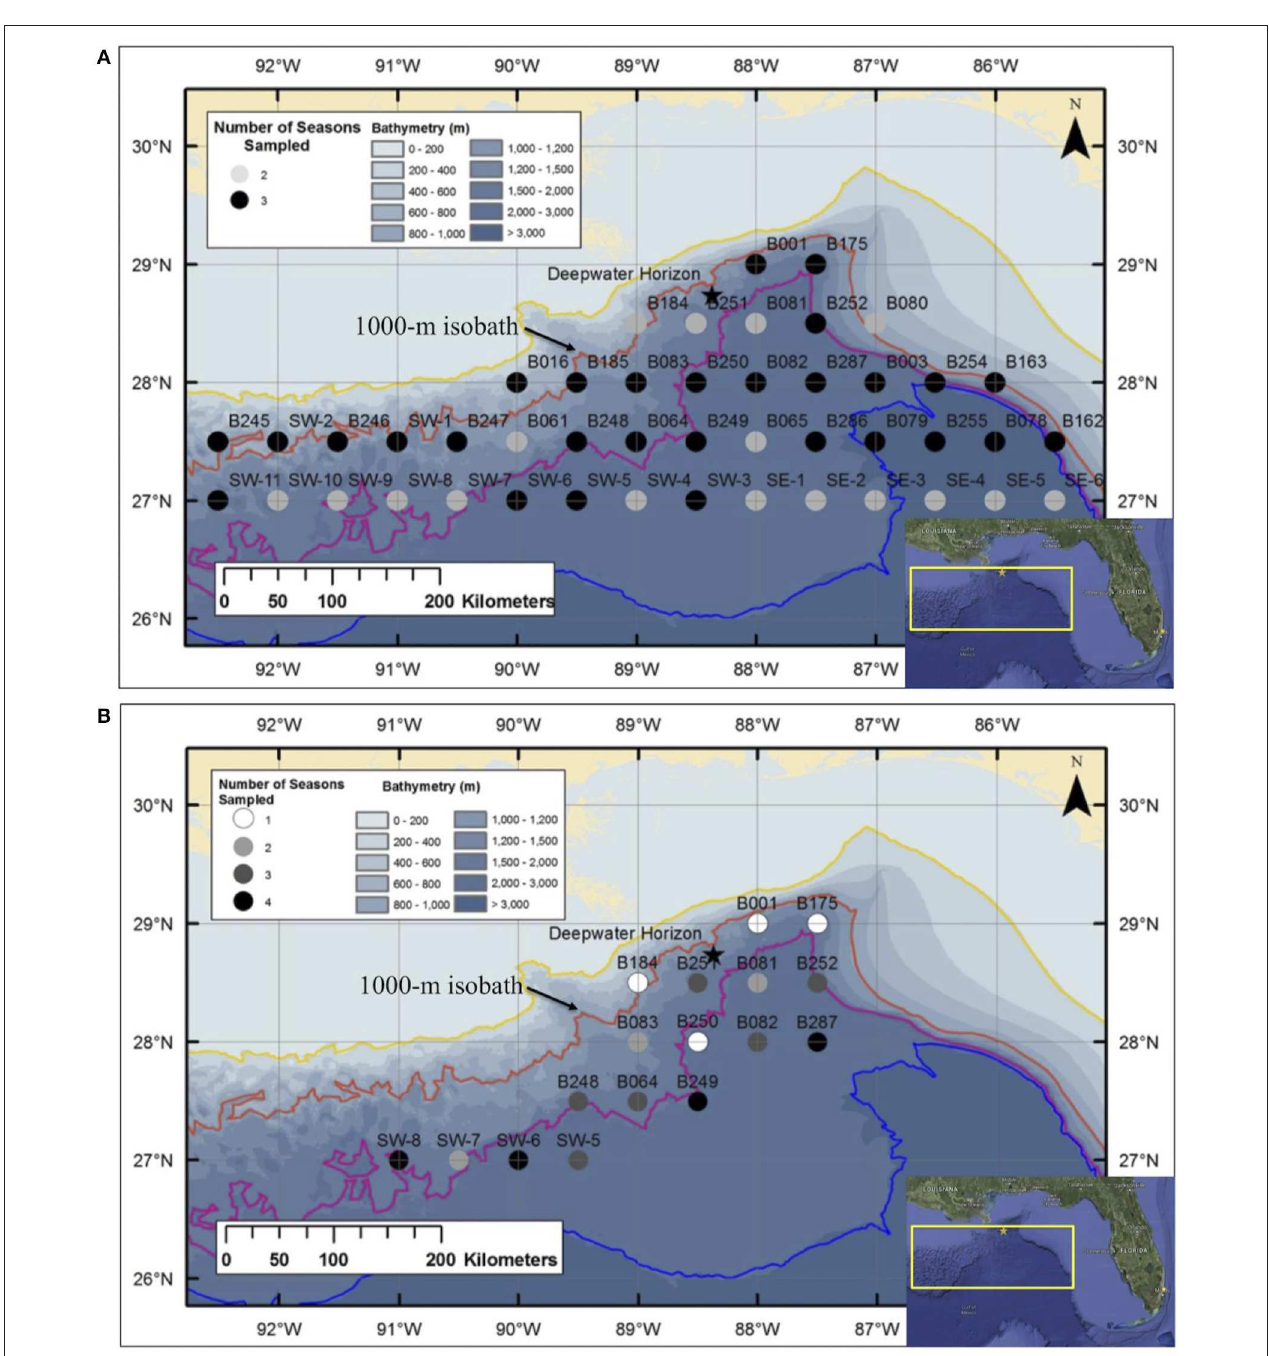
FIGURE 1 | Deepwater stations sampled in the Gulf of Mexico during: (A) Meg Skansi 6, Meg Skansi 7, and Meg Skansi 8 cruises between January and September 2011; and (B) Pisces 8, Pisces 9, Pisces 10, and Pisces 12 cruises between December 2010 and September 2011. All adjacent sampling stations were equidistant from each other by 30 nautical miles (55.6km). Isobaths, from top to bottom, indicate depths of 200, 1,000, 2,000, and 3,000m, respectively. The 1,000-m isobath is individually labeled for reference. The black star marks the site of the Deepwater Horizon oil spill that occurred between April and September